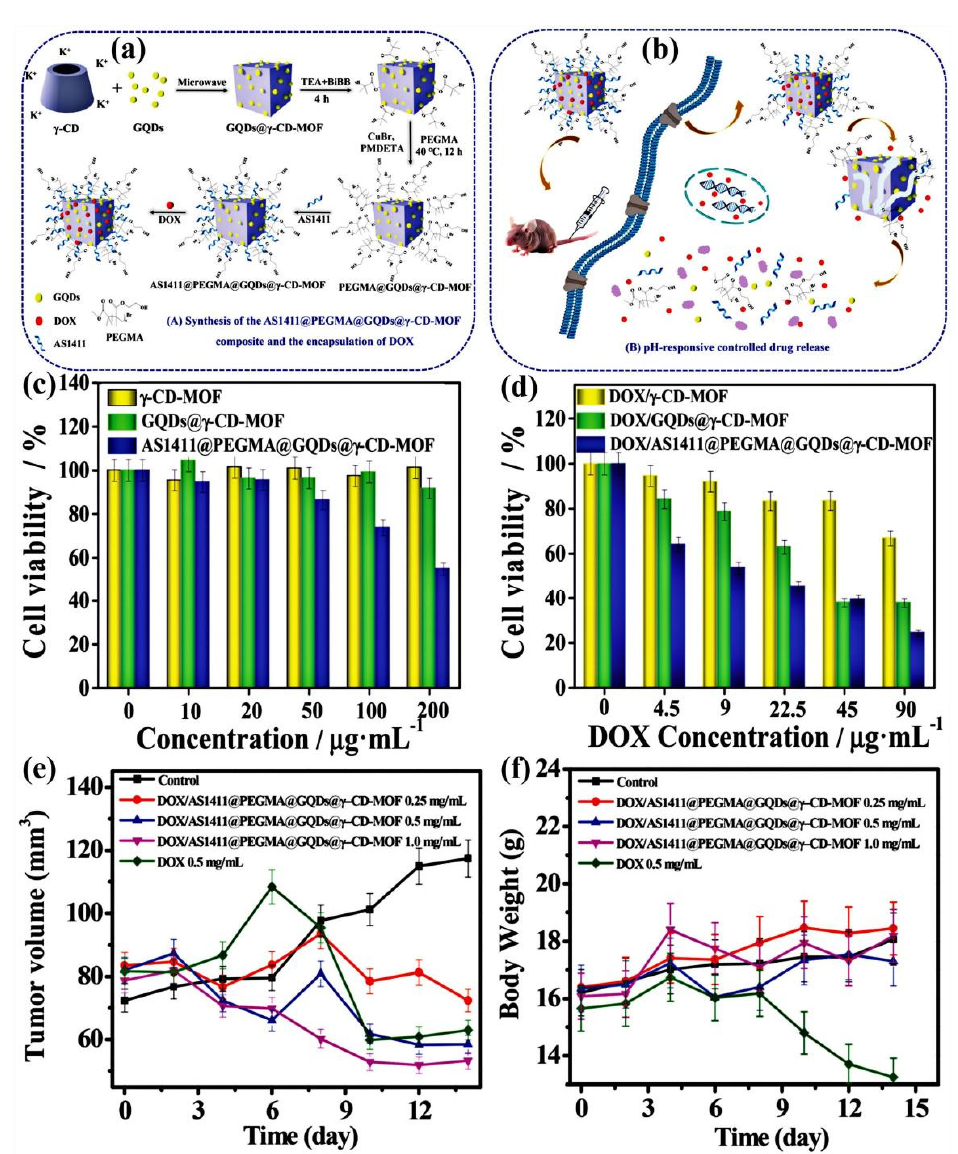
Figure 11. ( a ) Preparation of Dox/AS1411@PEGMA@GQDs@γ-CD-MOF and ( b ) its pH-responsive Dox release. ( c , d ) Cell viability of different carriers. ( e ) Tumor volume growth and ( f ) body weights of mice treated by drug-delivery systems. Reproduced with permission from Ref. [83], copyright (2019) the Royal Society of Chemistry.